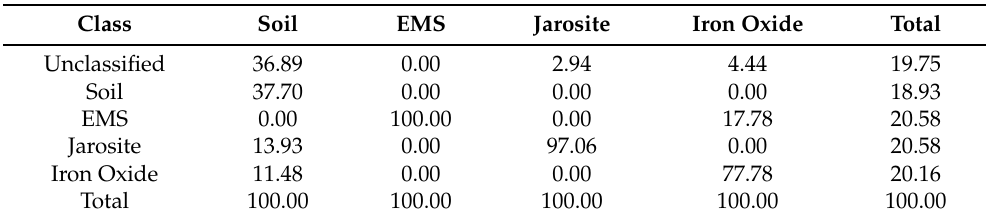
Table A4. September 2018 maximum likelihood. Overall accuracy points: 156/243, overall accuracy: 64%, kappa coefficient: 0.5543.